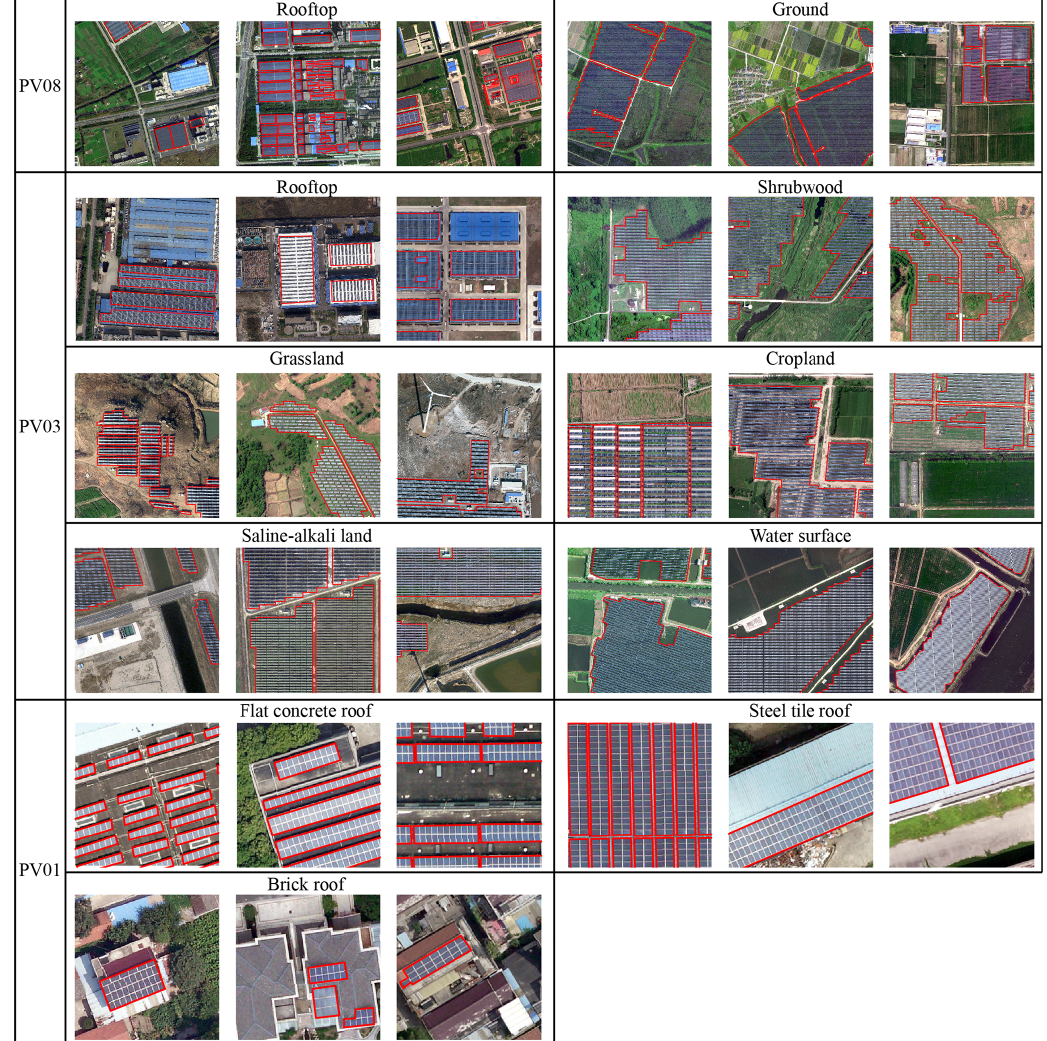
Figure 3. Examples of PV panels and their annotations. Red boxes indicate the boundaries of PV panels.